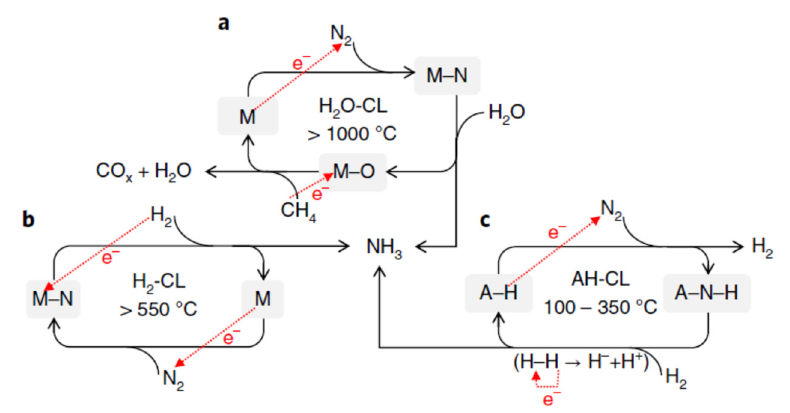
Figure 11. Ammonia synthesis by catalyst-assisted chemical looping: ( a ) H 2 O-CL process, ( b ) H 2 -CL process, ( c ) AH-CL process. Metal and the corresponding metal nitride and oxide are represented by M, M-N and M-O, respectively. A-H and A-N-H stand for alkali or alkaline earth metal hydride and imide, respectively [74].